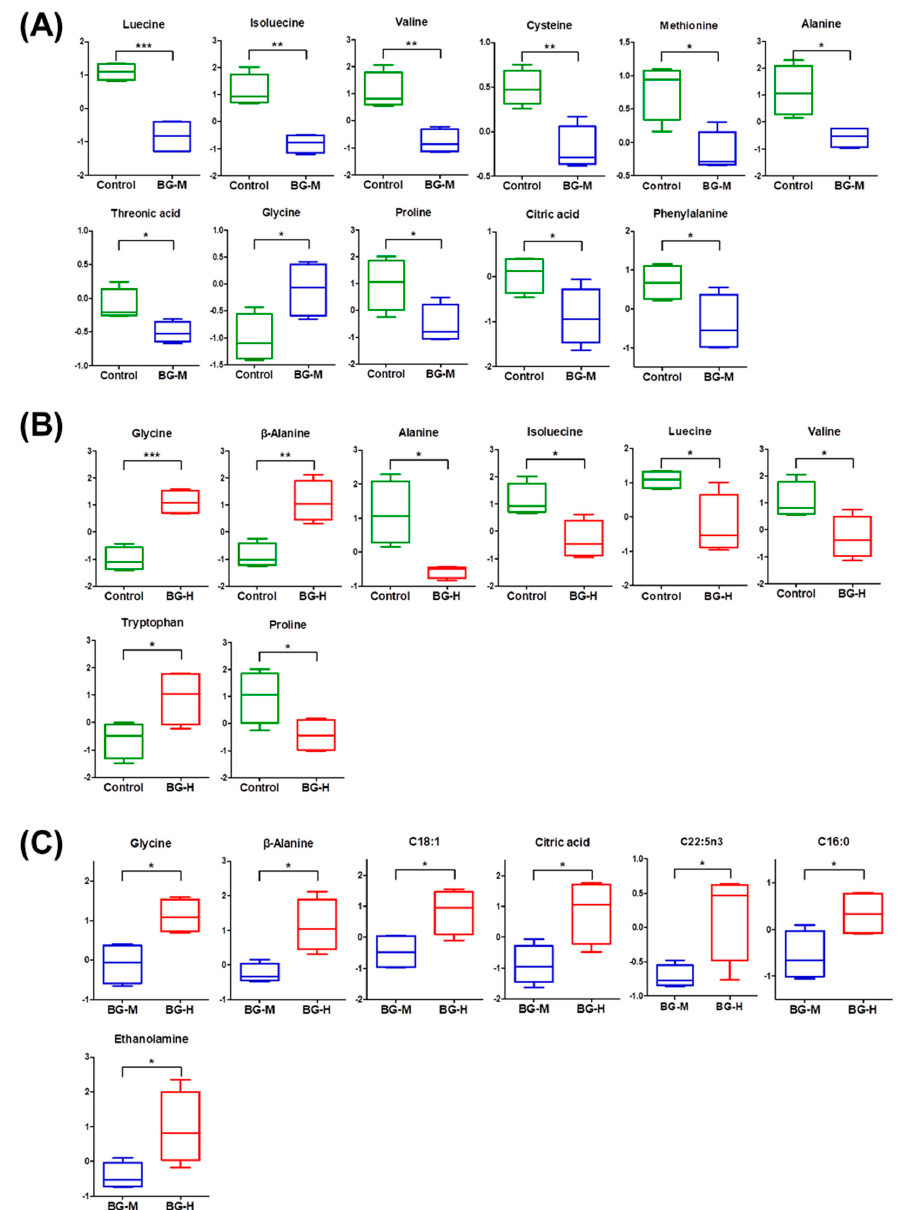
Figure 5. Box plots of metabolites that differed significantly (* p < 0.05, ** p < 0.01, *** p < 0.001) in the serum of beagle dogs between the control and BG-M groups ( A ), control and BG-H ( B ), and BG-M and BG-H groups ( C ). Fatty acid formula is: C (number of carbon atoms): (number of double bonds) nx (position of double bonds). Control, a regular diet; BG-M, regular diet with a medium concentration of BG extract; BG-H, regular diet with a high concentration of BG extract; C16:0, palmitic acid; C18:1, oleic acid; C22:5n3, docosapentaenoic acid.